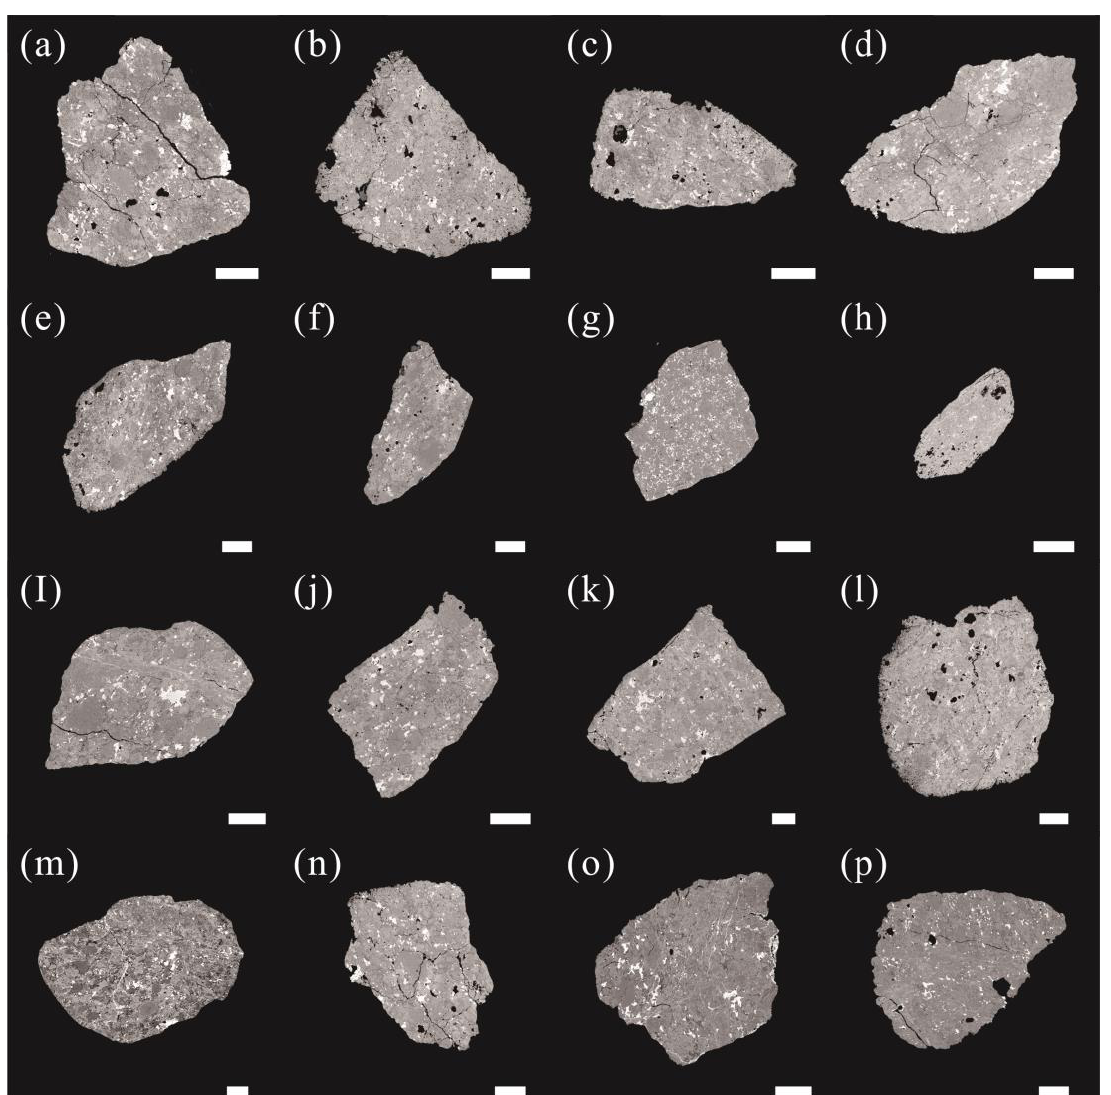
Figure 1. BSE images of 16 samples selected for the study. ( a ) GRV 090360; ( b ) GRV 090361; ( c ) GRV 090363; ( d ) GRV 090376; ( e ) GRV 090379; ( f ) GRV 090380; ( g ) GRV 090403; ( h ) GRV 090421; ( i ) GRV 090448; ( j ) GRV 090449; ( k ) GRV 090463; ( l ) GRV 090511; ( m ) GRV 090517; ( n ) GRV 090519; ( o ) GRV 090520; ( p ) GRV 090521. All pictures are thin section scans. The white bar corresponds to 2 mm. Table 1. Information on the selected meteorite samples (analysis of these sample components was conducted by electronic probes and raw data provided by the Meteoritical Bulletin Database).